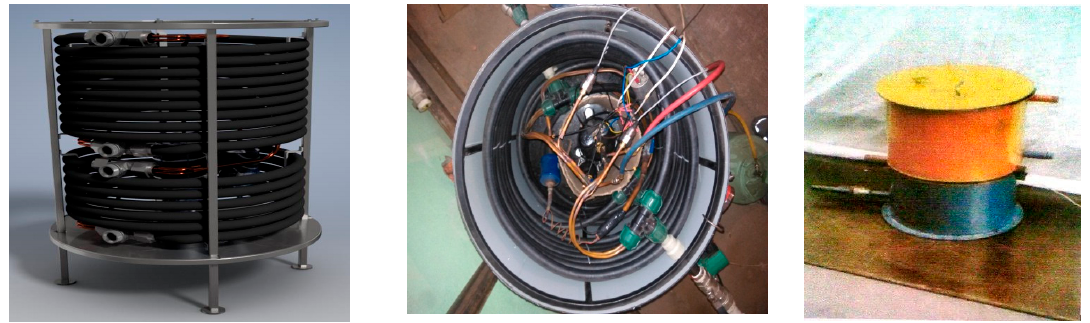
Figure 2. Schematic diagram of the heat pump.